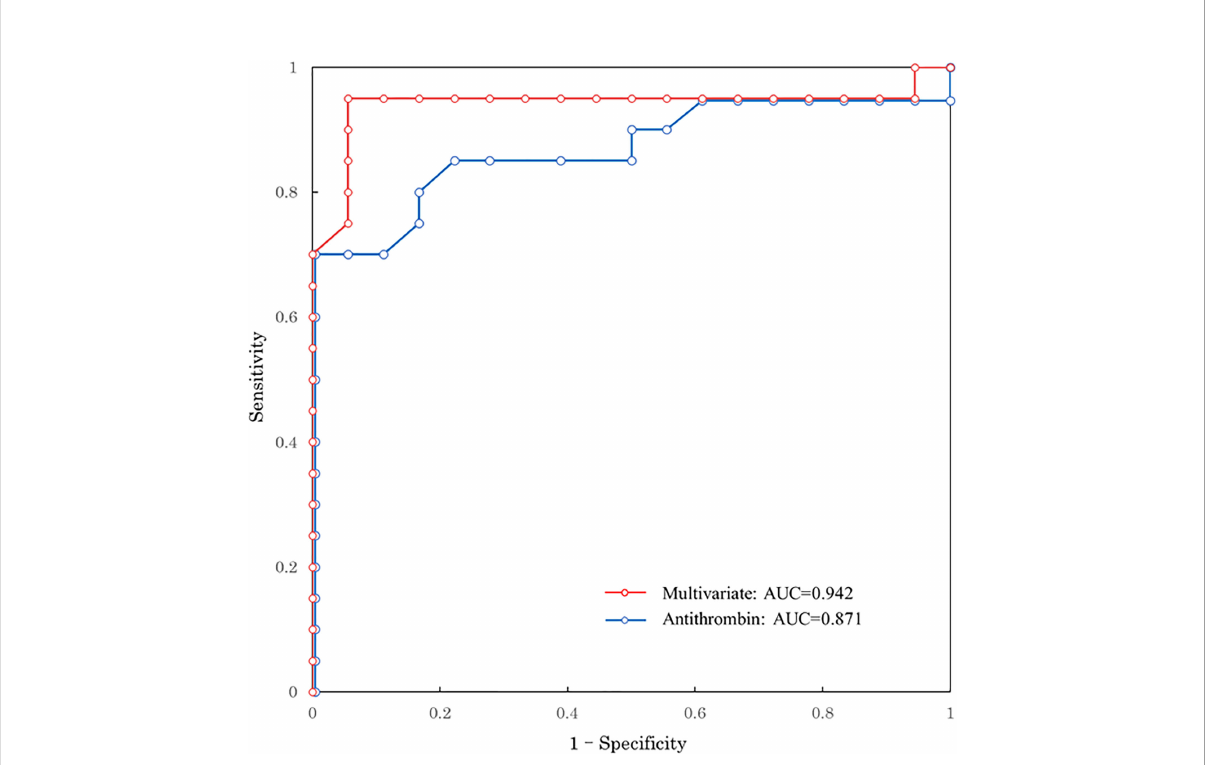
FIGURE 1 ROC curve predicting long-term neurological outcome. Red line: multivariate logistic regression model with age, GCS, ISS, and antithrombin 1 h after injury Blue line: univariate of antithrombin 1h after injury. ROC, receiver operating characteristic; AUC, area under the ROC curve; GCS, Glasgow Coma Scale; ISS, Injury Severity